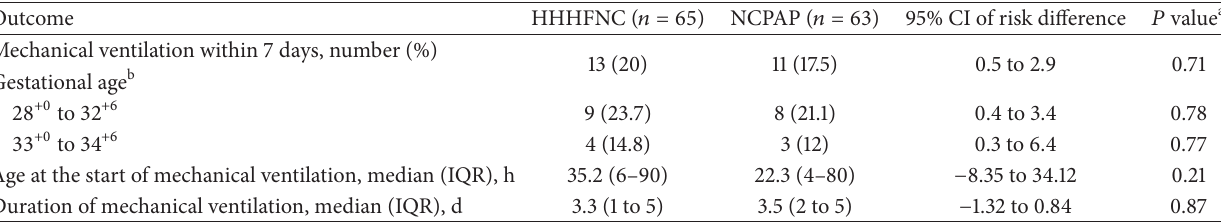
Table 2: Primary outcome